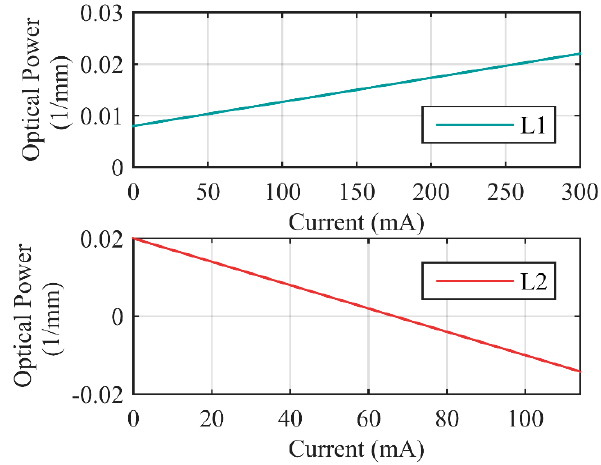
Figure 4. Optical power of the liquid lenses as functions of control currents.